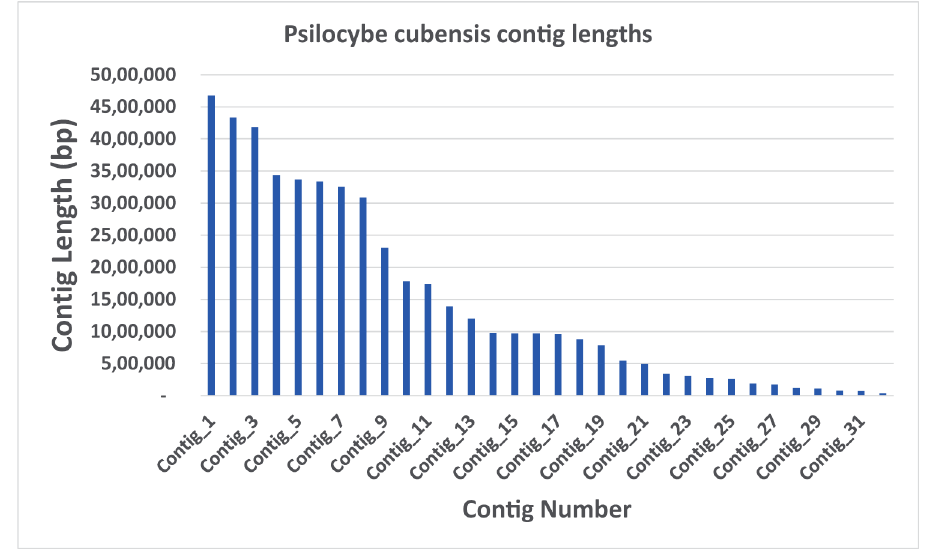
Figure 1. Psilocybe cubensis P.envy contig length distribution (n = 32).